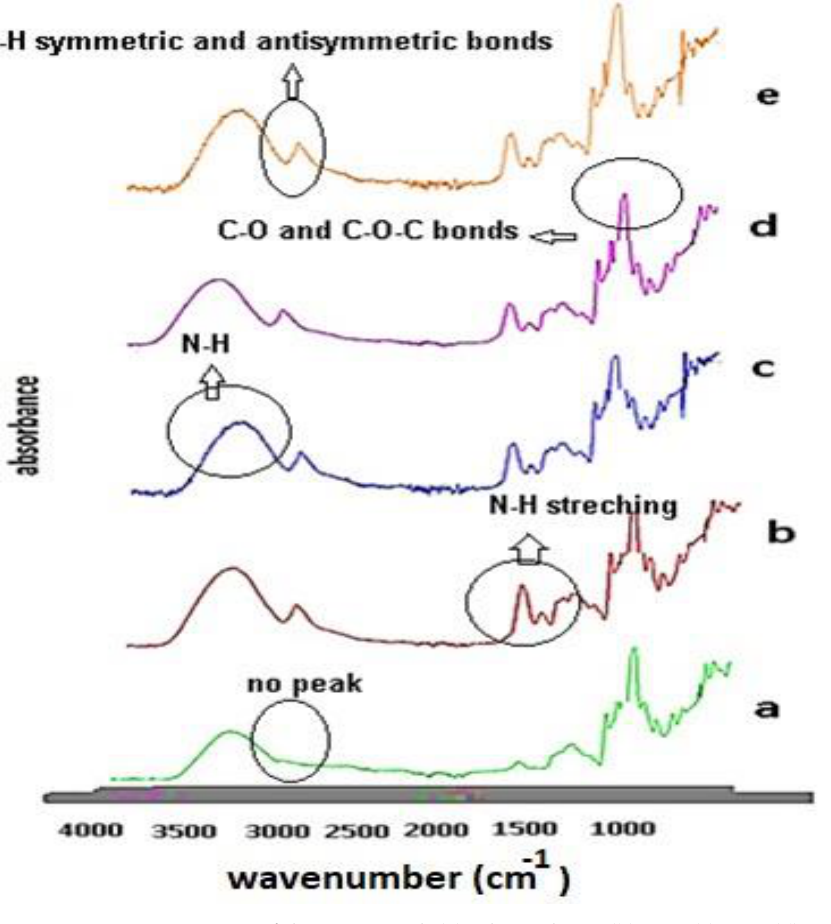
Figure 2. FTIR_ATR spectra of the corn starch ( a ),wheat gluten ( b ), CS 1 ( c ), CS 2 ( d ), and ve CS 3 ( e ) silver nanofilms.